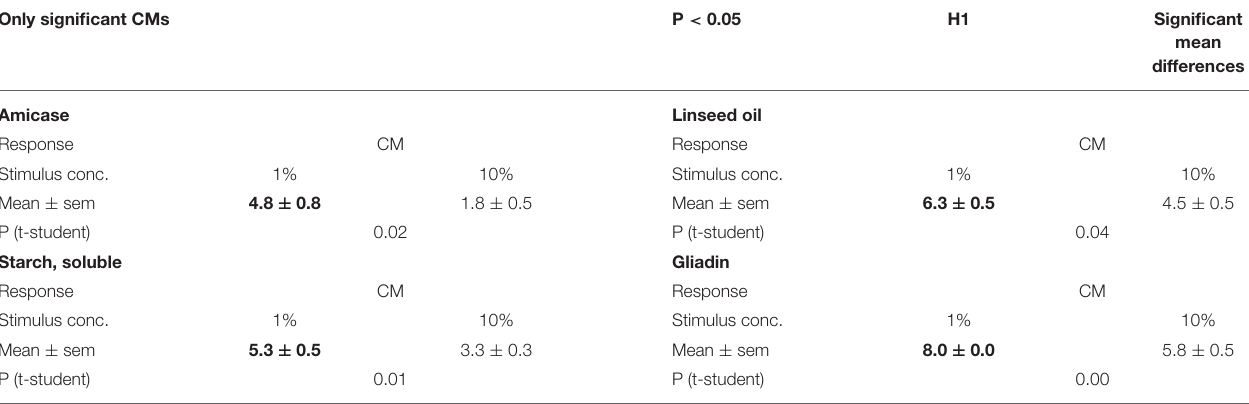
TABLE 3 | Comparisons of 20 chemical stimuli at 1 and 10% concentration presented as single simulacra, i.e., without concurrent blank simulacra. Only significant CMs P < 0.05